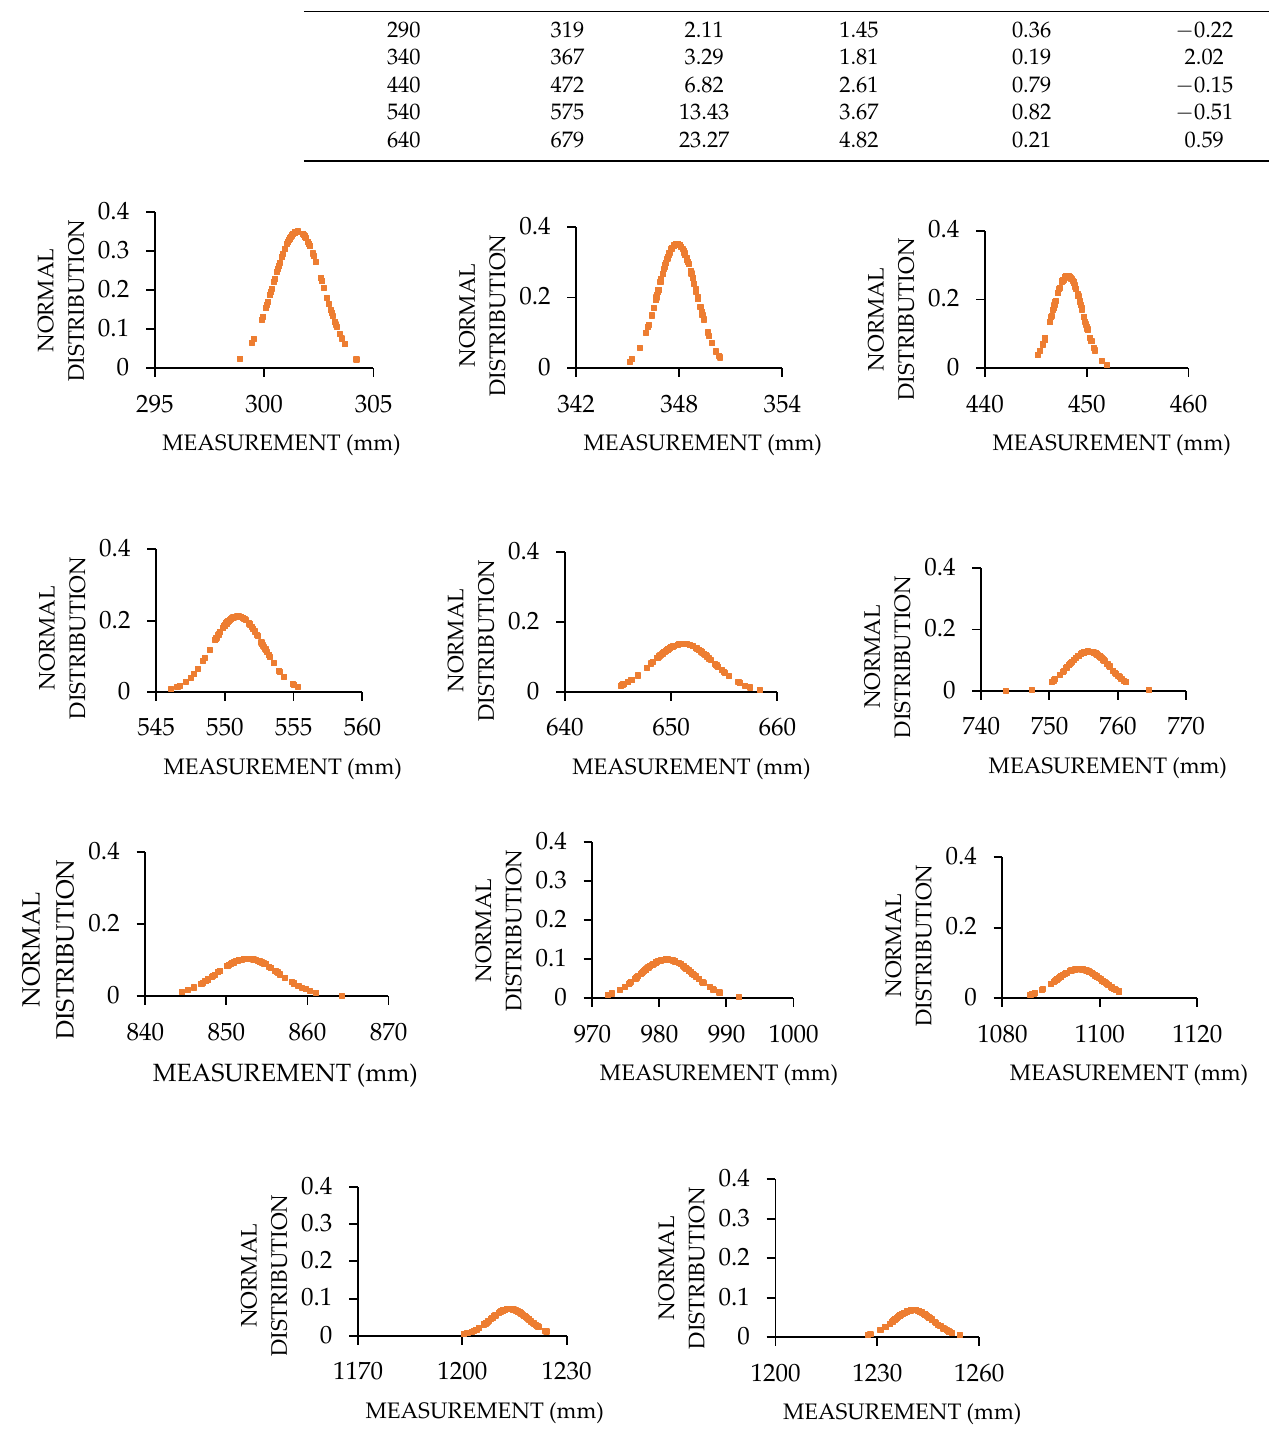
Figure 15. The normal distribution function of VL53L1X for tests with no excessive ambient light. Table 7. Statistical analysis of VL53L1X for tests with no excessive ambient light.